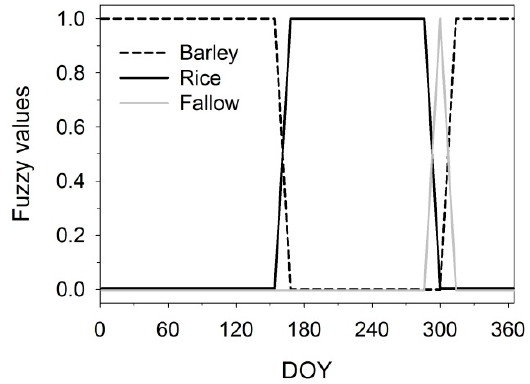
Figure 3. Fuzzy transformation of the cultivation for the study site based on the cultivation information from Kwon et al. [15]. DOY: day of year